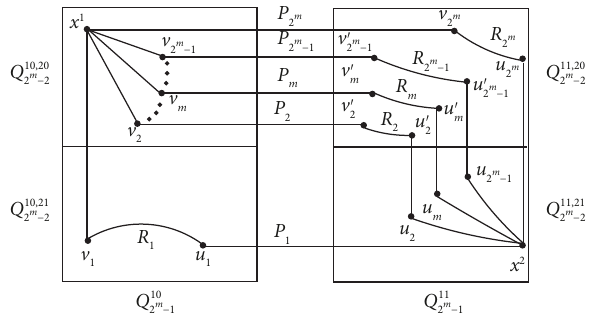
Figure 11: Te illustration of d